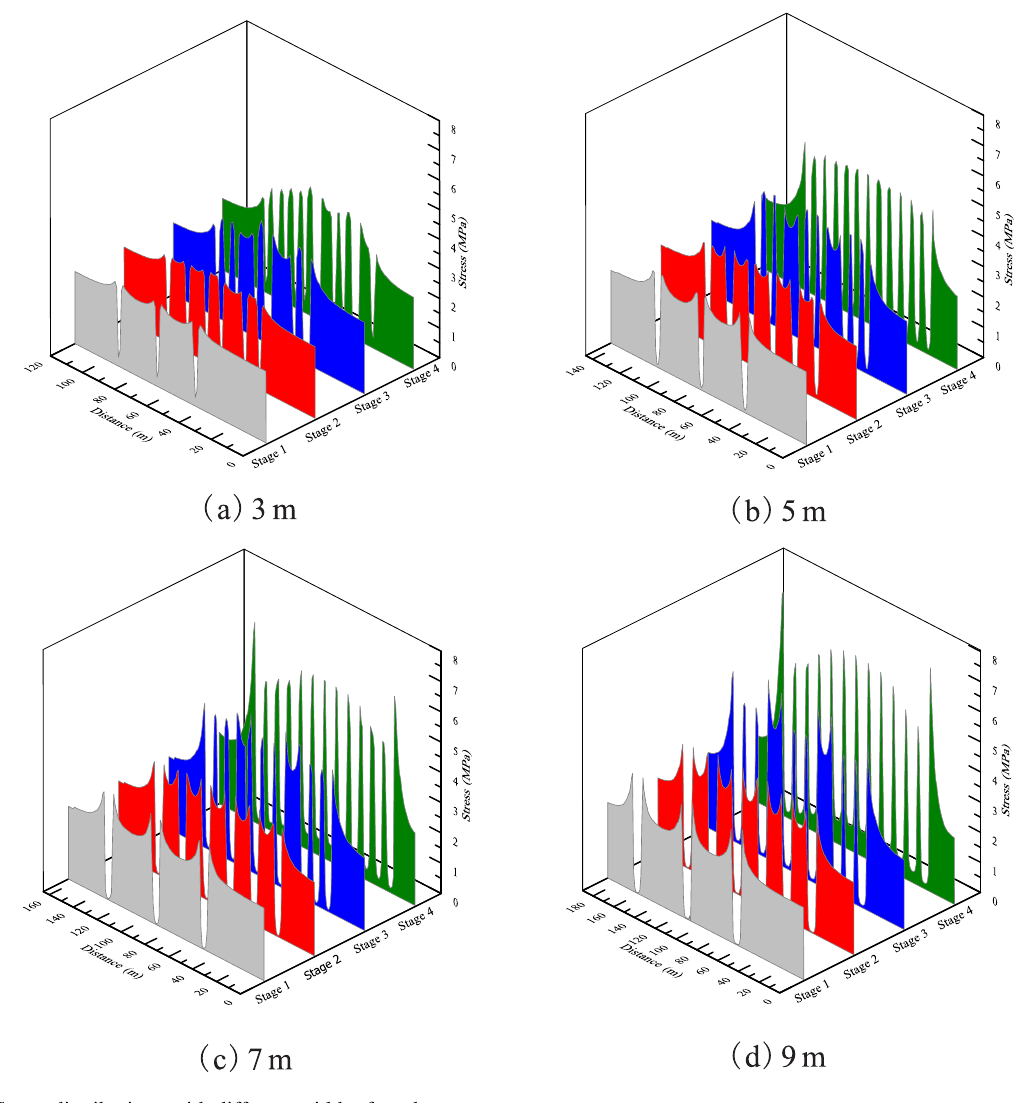
Figure 11. Stress distributions with different width of roadway.